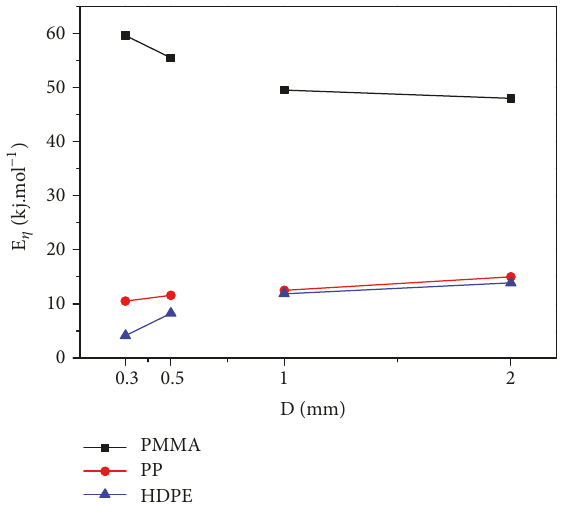
Figure 2: Viscous flow activation energy at both microscales and macroscales with the shear rate of 5000 s −1